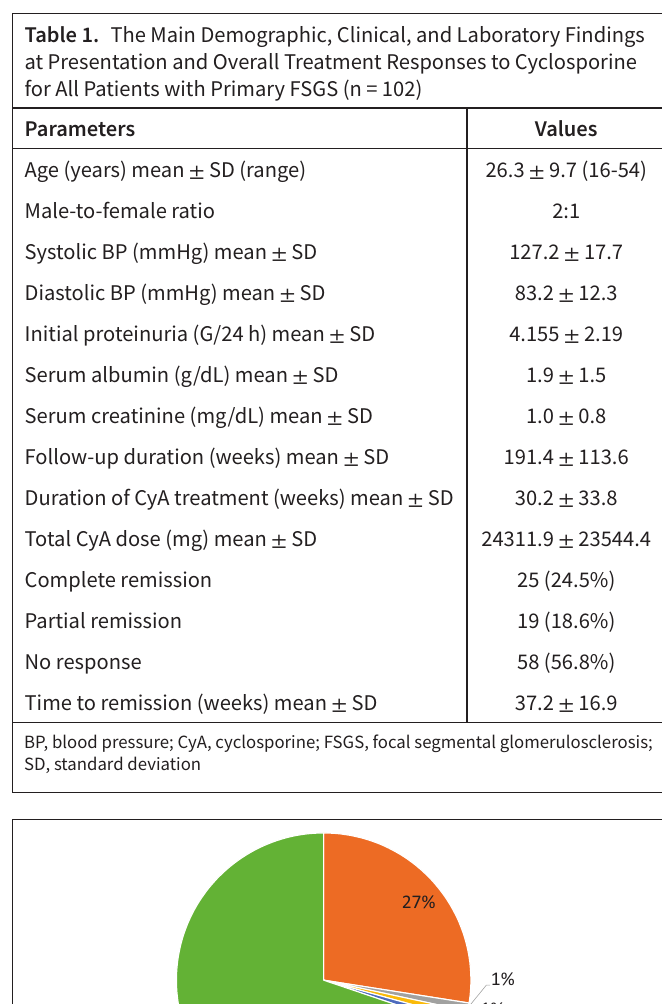
Table 2. Comparison of Demographic, Clinical, Laboratory, and Treatment Response to Cyclosporine Parameters Among